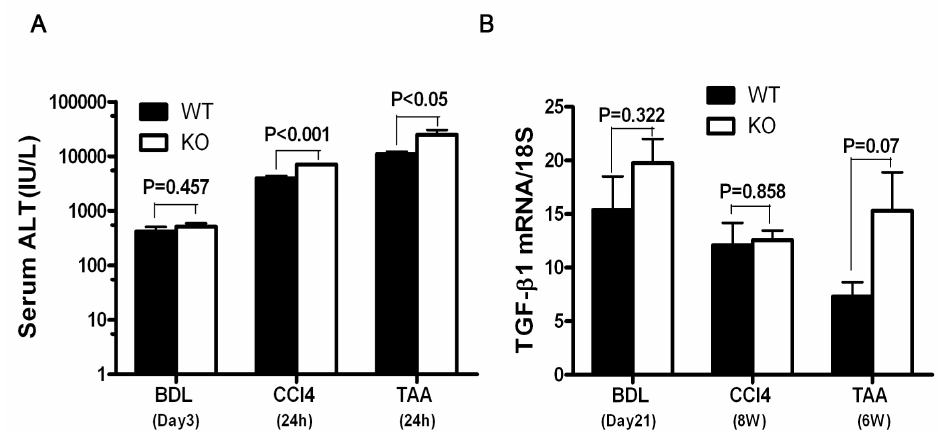
Figure 3. SULF2 affects activation of the TGF signaling pathway in mice liver fibrosis. ( A ) Serum ALT levels in mice with liver fibrosis. ( B ) TGF- β 1 transcript levels in fibrotic mice liver tissue. Data shown are representative of ten mice per group and are presented as mean ± SEM.